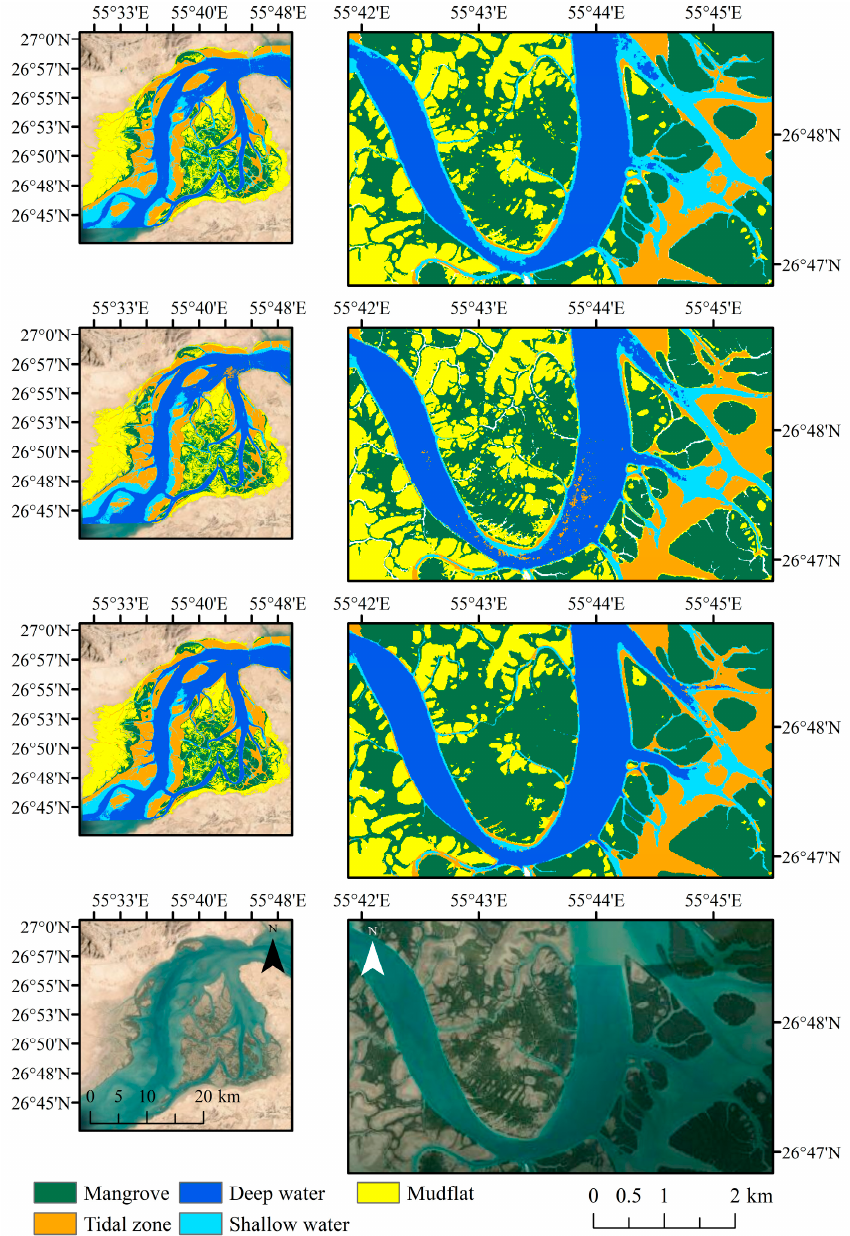
Figure 8. Mangrove ecosystem classified maps using the ANN models with three learning algorithms of Adam ( first row ), LBFGS (second row ), and SGD ( third row ), along with the corresponding very high ‐ resolution images ( fourth row ) over the study area.